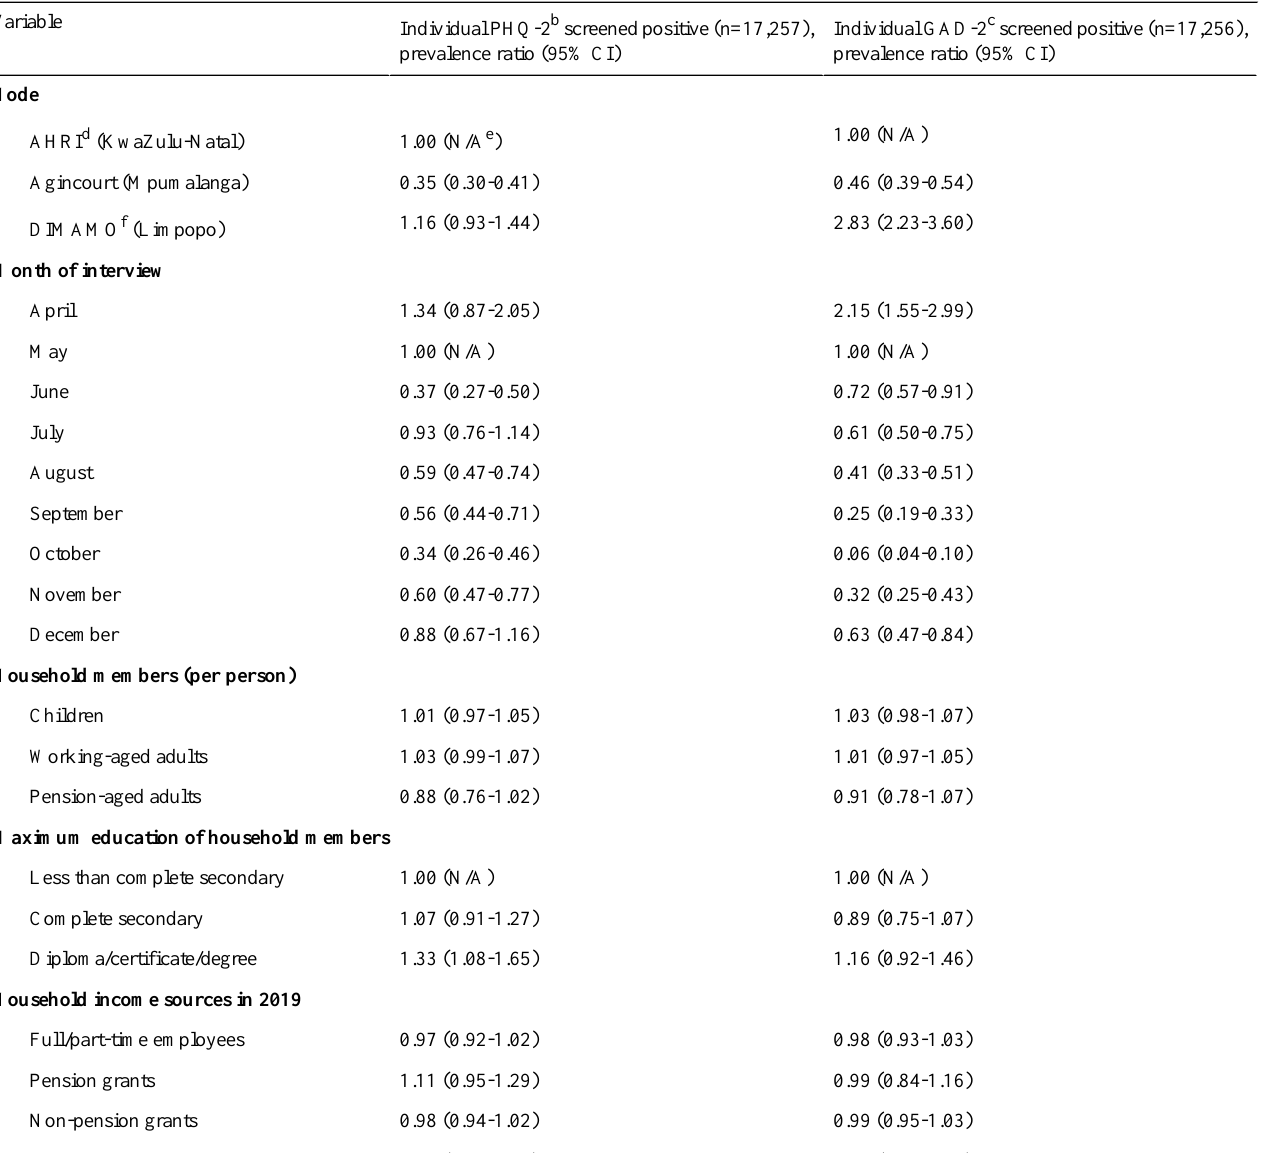
Table 5. Mental health impacts of COVID-19 and household characteristics at South African Population Research Infrastructure Network nodes